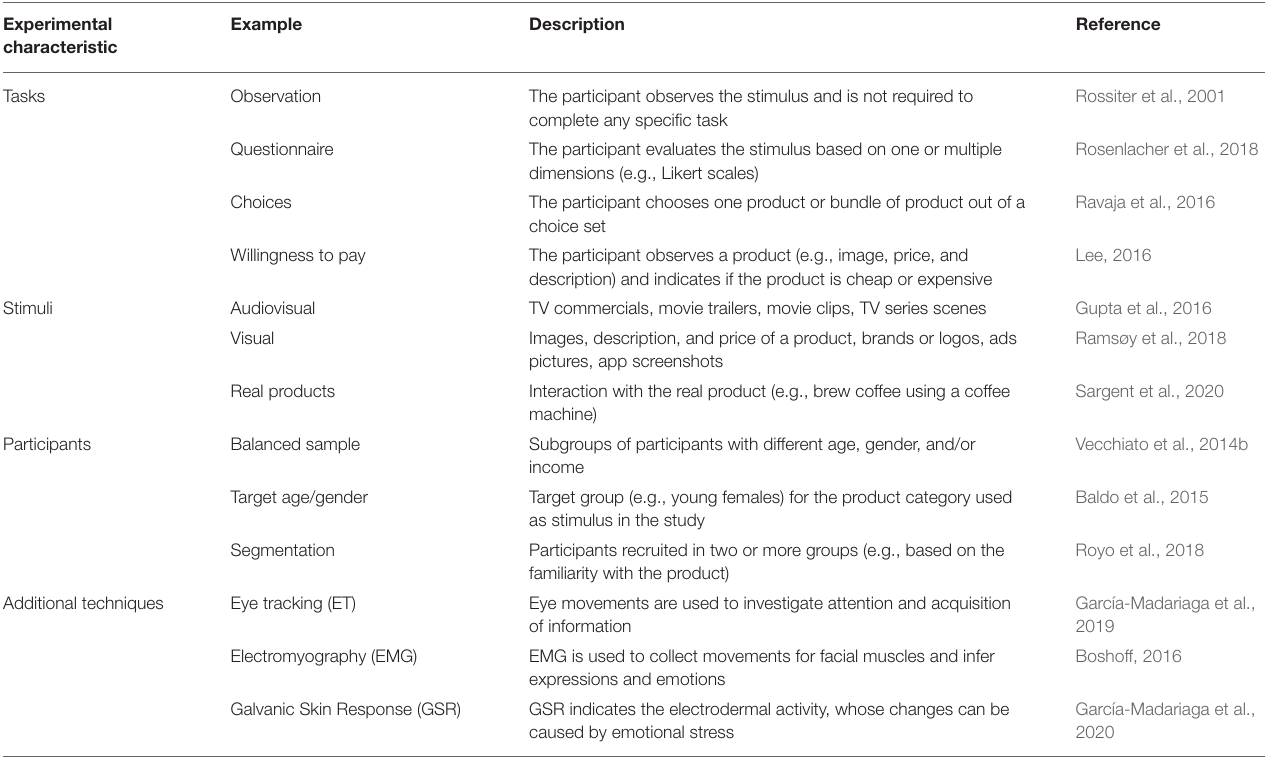
TABLE 2 | Experimental characteristics: tasks, stimuli, participants, and additional